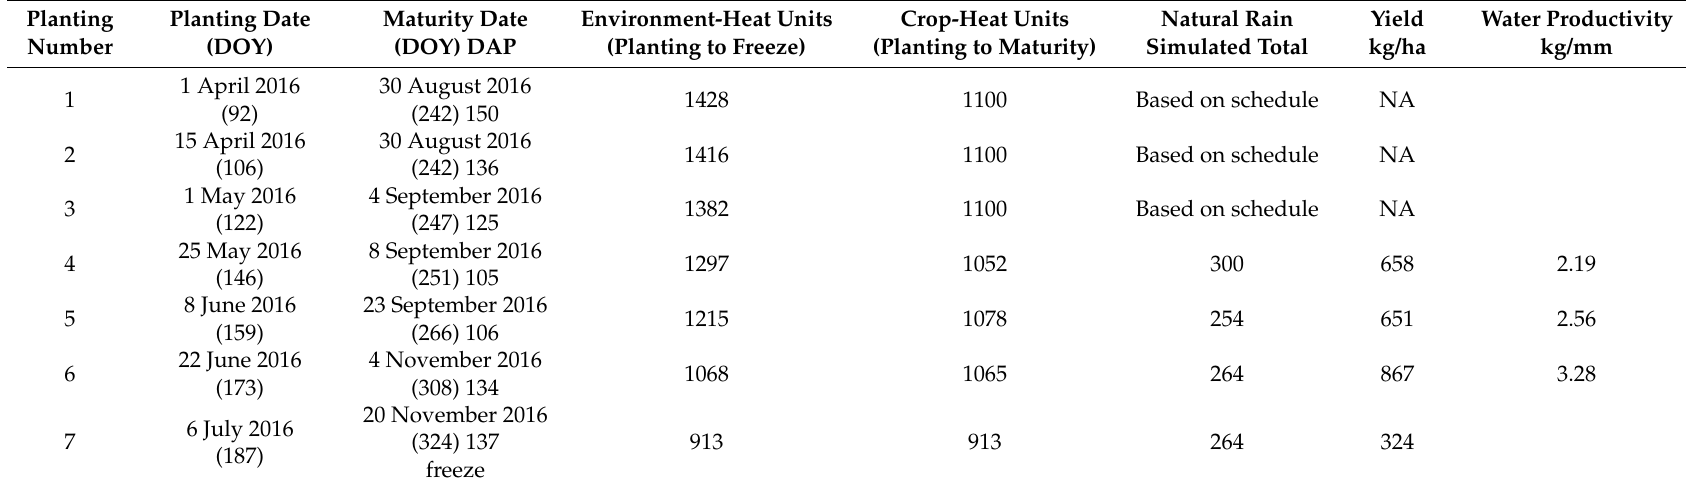
Table 1. 2016 Summary.